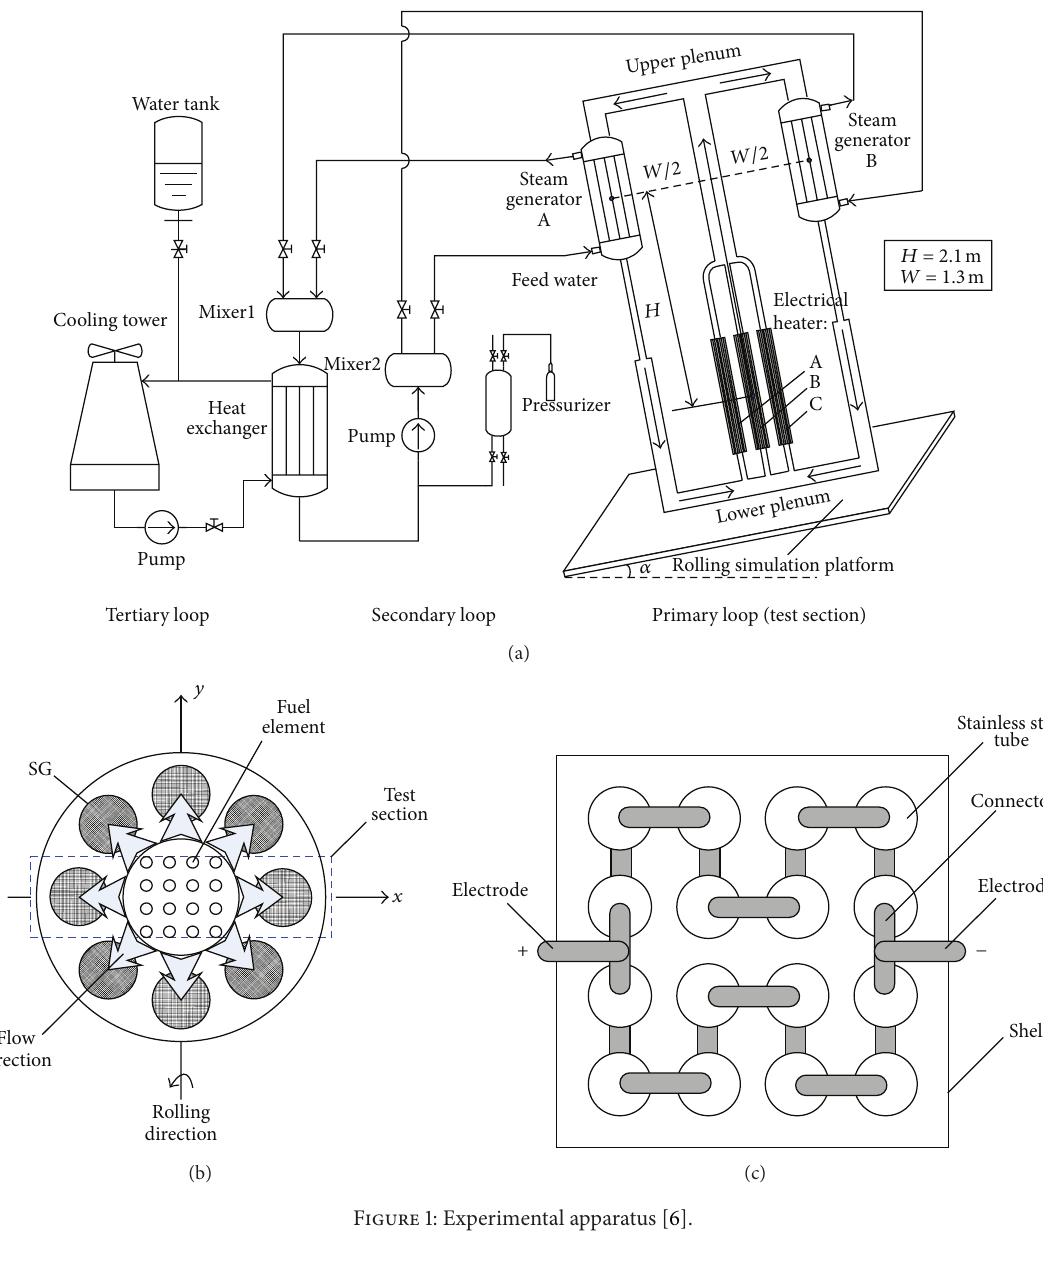
Figure 1: Experimental apparatus